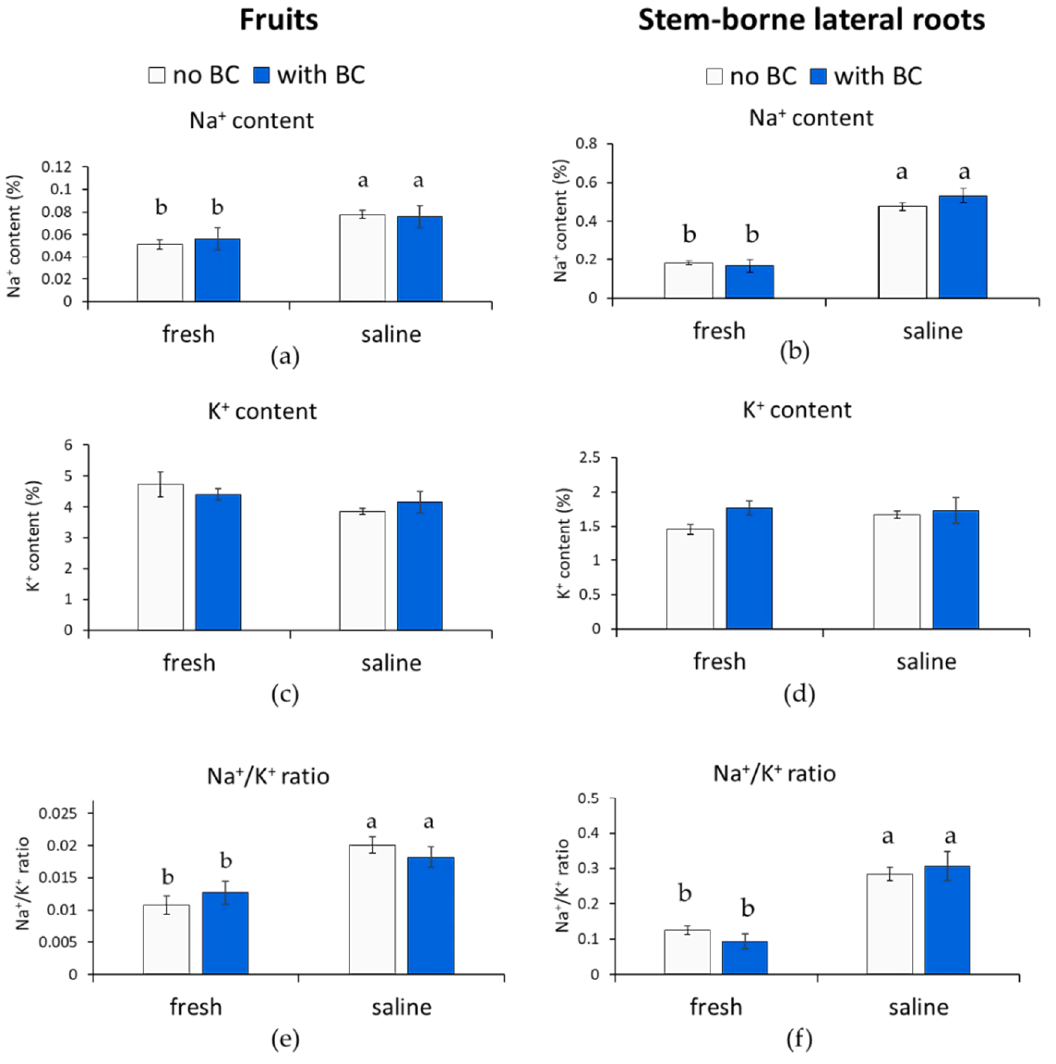
Figure 3. Effect of biochar addition on accumulated Na + content in fruits ( a ), K + content in fruits ( c ), Na + /K + ratio in fruits ( e ), Na + content in stem-borne lateral roots ( b ), K+ content in stem-borne lateral roots ( d ), and Na +/ K + ratio in stem-borne lateral roots ( f ). Values represented the means of four biological replications (three plants each) ± SE (n = 96, two seasons). Means with the same letters are not significantly different according to Duncan’s multiple range test (DMRT) ( p ≤ 0.05).